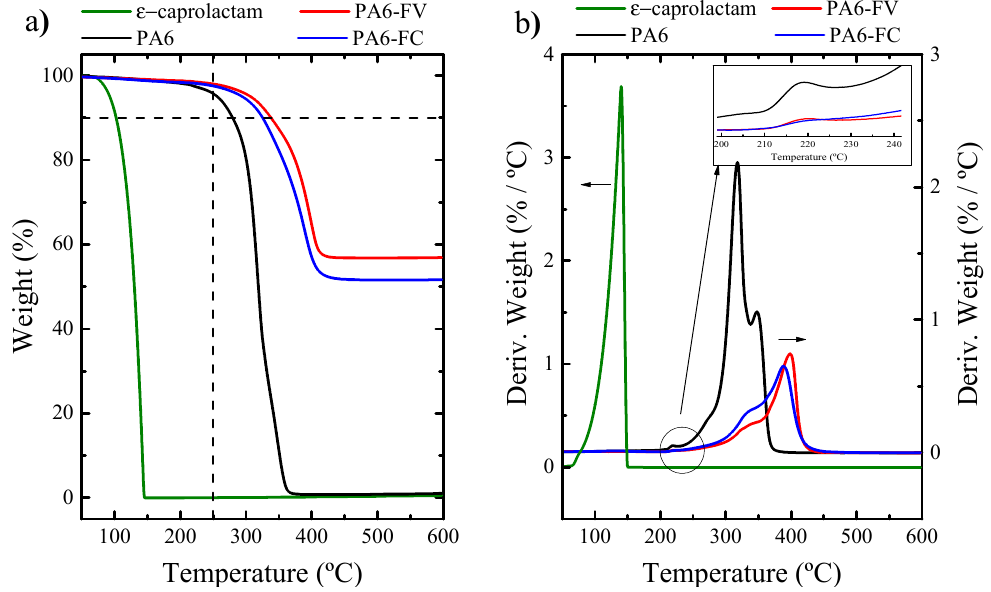
Figure 2. TGA results, expressed as weight as a function of temperature ( a ) and its derivative ( b ) for neat PA6, the indicated composites and for the ε -caprolactam monomer at 5 °C·min − 1 .